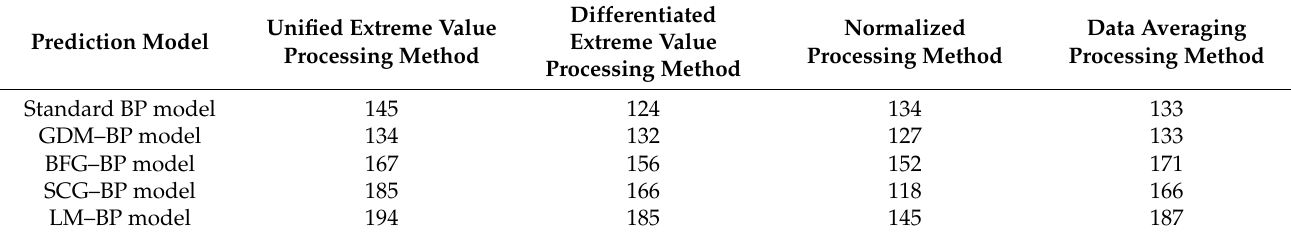
Table 3. Comprehensive, accurate values C of different models.